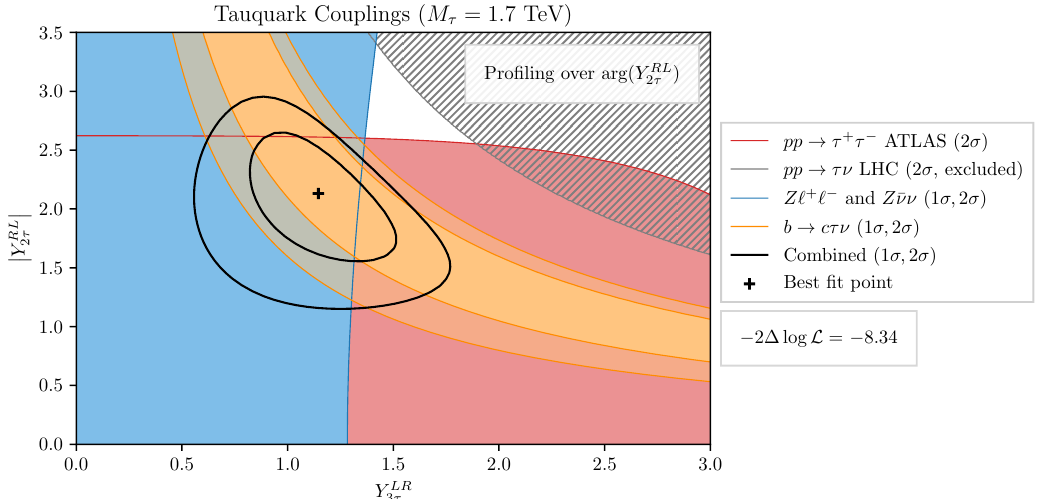
anomalies D ( ∗ ) is real and we profile over 3 τ